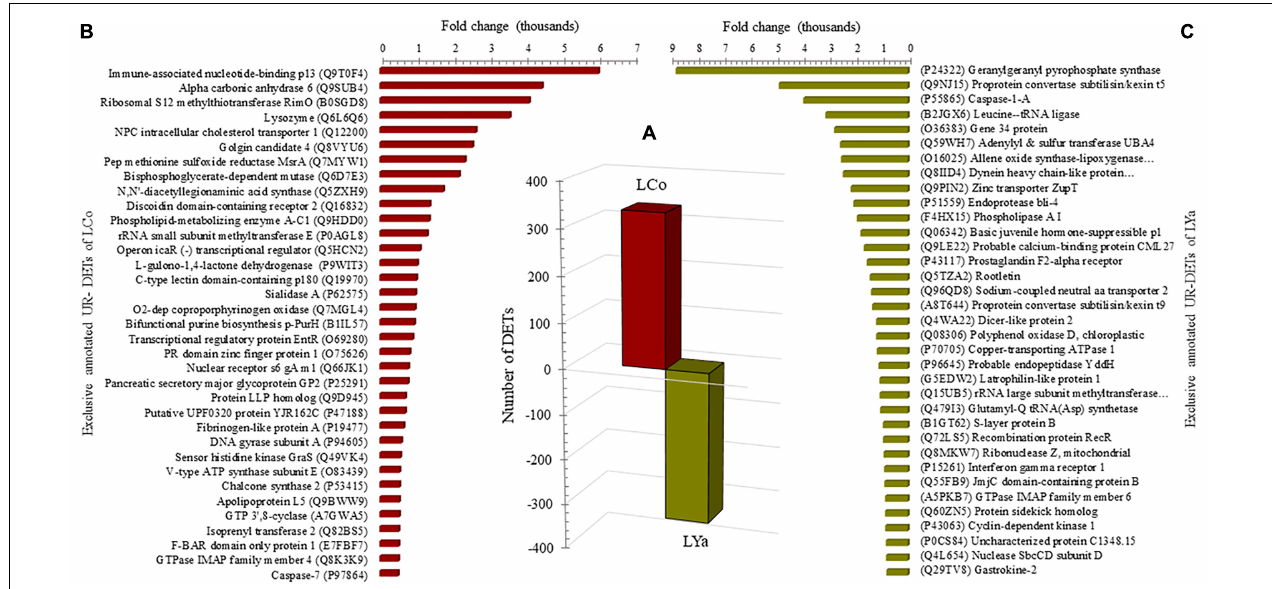
FIGURE 5 | Comparison by location. The number of differentially expressed transcripts (DETs) by location (bars) are in the central plot (A) ; the number of the up-regulated (UR-) DETs of samples from Yaldad are in negative values. Also are showed, sorted by fold change, the top thirty-five exclusive annotated UR-DETs for samples from Cochamó (B) and Yaldad (C) . LCo, local individuals from Cochamó and LYa, locals from